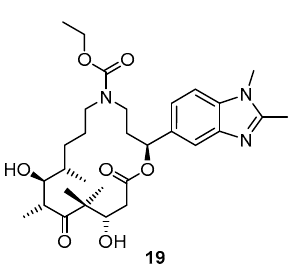
Figure 3. Molecular structure of azathilone 19 .